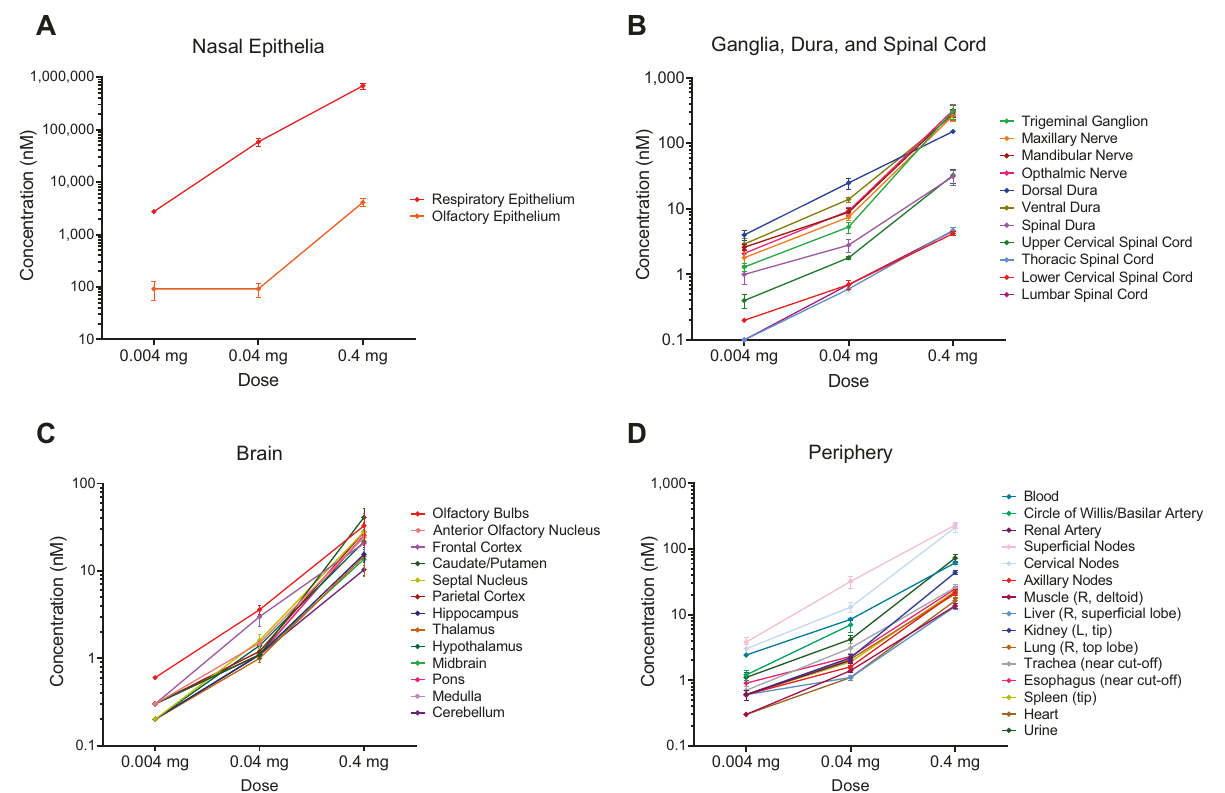
Fig. 2 Quanti fi cation of 125 I-oxytocin (OT) concentrations following intranasal administration, throughout central and peripheral tissues. A A dose-dependent signal was detected in both extra-olfactory and olfactory epithelia. B Dose-dependent concentrations of 125 I-OT were detected throughout the dura, ganglia, and spinal cord. Concentrations were particularly high in the trigeminal ganglia and maxillary, mandibular, and ophthalmic nerve branches as well as the dorsal and ventral dura, both of which are also innervated by the trigeminal nerve. C Dose-dependent concentrations of [ 125 I]-radiolabeled OT were detected throughout the brain regions assayed. At the 0.4 and 0.04 mg doses, the olfactory bulb and frontal cortex had markedly higher concentrations relative to most other brain regions. In this time course, i.e., 30 min post administration, this distribution is consistent with OT transport directly to the brain via an extraneuronal transport mechanism. High concentrations in the pons and medulla are consistent with transport along the trajectory of the trigeminal nerve. The high concentrations in the caudate/putamen (0.4 mg dose) as well as in the parietal cortex and septal nucleus may re fl ect regions of OT-receptor binding or accumulation along major CSF drainage pathways in the brain. D OT was detected in dose-dependent concentrations across peripheral tissues. The elevated concentrations in super fi cial and cervical nodes relative to blood and urine concentrations may re fl ect drainage of CSF into local tissue lymphatics and accumulation in local lymph tissue. See Table 1 and Supplemental Materials for receptors [20] had an adequate concentration for possible olfactory epithelium but lower in the olfactory epithelium when activation of OT receptors (1.3 – 2.6 nM) even at this dose as has compared to animals that did not receive mucoadhesive. This may the dorsal dura matter (4.0 nM). The 0.04 mg dose resulted in be a result of the increased viscosity of the dosing solution concentrations that were low that may still feasibly activate OT containing mucoadhesive, which makes it more dif fi cult to move receptors. For visual comparison, concentrations in epithelia; all the way up past the turbinate to the olfactory epithelium at the brain, dura, and spinal cord; brain; and peripheral tissues were roof of the nasal cavity. Mucoadhesive also increased OT plotted across doses to evaluate the dose – response relationship concentrations in the dorsal and ventral dura at 30 min. These fi ndings encourage studies with extended time points to of intranasal OT. As seen in Fig. 2 and Table 2, the concentration of OT across all tissues examined increases as the dose of intranasal investigate the advantage of mucoadhesive as a function of time. OT increases. Qualitative autoradiography studies completed on animals receiving [ 125 I]-OT with 1% Avicel ™ mucoadhesive resulted in a Study 4: effect of time similar distribution to animals that received [ 125 I]-OT without the Both animals at 60 min post 0.4 mg/kg IN OT delivery had high mucoadhesive. The highest intensity was achieved in the enough concentrations to feasibly activate OT receptors in all trigeminal nerves, olfactory bulbs, and frontal cortex. brain tissues. In the trigeminal system, concentrations were especially high. Table 3 demonstrates that in the majority of Study 3: effect of dose brain regions (with the exception of the frontal cortex), the animal Table 2 reports mean concentrations in the brain and periphery receiving mucoadhesive had lower brain tissue concentrations after administration of 0.04 mg, and 0.004 mg of labeled OT, than the animal receiving only [ 125 I]-OT. In addition, the blood and respectively (see Table 2 for comparison to the 0.4 mg dose). Brain penetrance with the 0.004 mg dose this dose was low, with all majority of the peripheral tissues also had lower concentrations of brain-region concentrations essentially equal, at 0.2 to 0.3 nM, too OT in the animal receiving the mucoadhesive (Table 3). The animal low a concentration to feasibly activate OT receptors. However, receiving the mucoadhesive had higher concentrations of OT in the trigeminal nerve and ganglia, which express functional OT the trigeminal ganglion, maxillary nerve, mandibular nerve, and